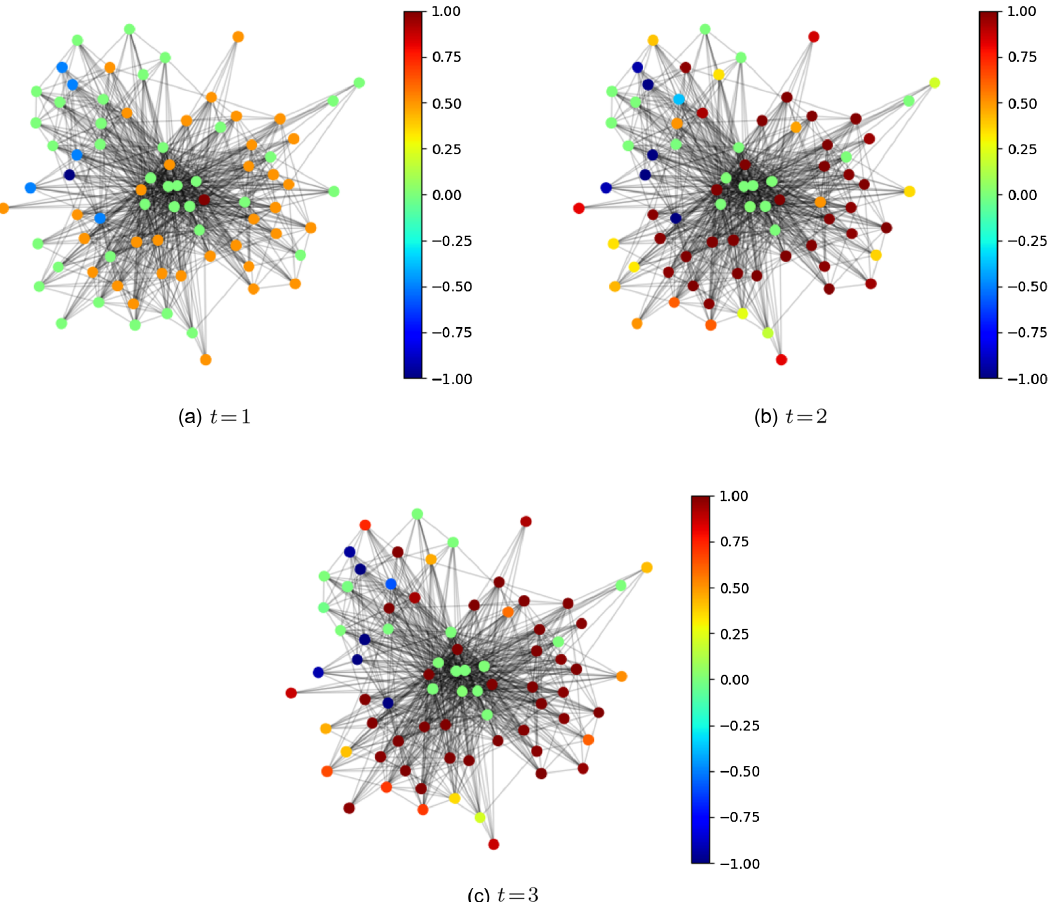
FIG. 11. Example of optimization of competitive processes on the 1994 network of world trade in metal. The infection parameters used for the two processes are α A ¼ α B ¼ 0 . 5 ; the budget for B is 1, allocated at node 1 (Argentina) at t ¼ 0 . A budget of 1 per time step is deployed using the DMP-optimal strategy for process A for a time window of T ¼ 3 . The subfigures represent the containment of process B at the different times: (a) t ¼ 1 ; (b) t ¼ 2 ; and (c) t ¼ 3 . The heat bar represents the dominating process per node through the value P i A ð t Þ − P i B ð t Þ . Red and blue represent dominating processes A and B ,